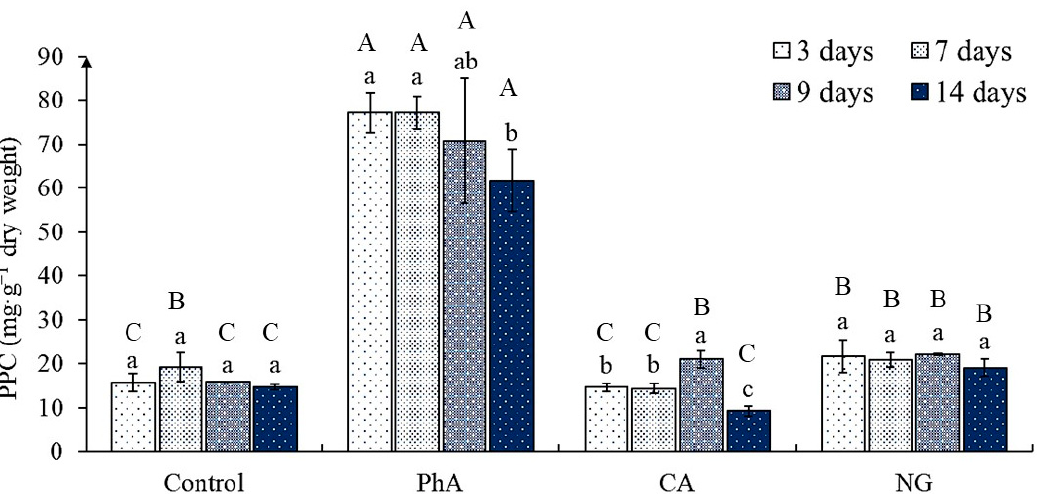
Figure 3. The phenylpropanoids content (PPC) in tea callus cultures of various ages grown on the liquid Heller culture medium of the basic composition (Control) or enriched with L -phenylalanine (PhA; 3 mM), trans -cinnamic acid (CA; 1 mM) or naringenin (NG; 0.5 mM). Results are expressed as means ± SDs, n = 3. The significant differences at p < 0.05 are denoted by different Latin letters: uppercase letters indicate significant differences between precursor treatments in alphabetic order from highest to lowest, lowercase letters indicate significant differences between duration of pre- cursor treatments in alphabetic order from highest to lowest. Pairwise multiple comparisons were carried out using Tukey’s range test.